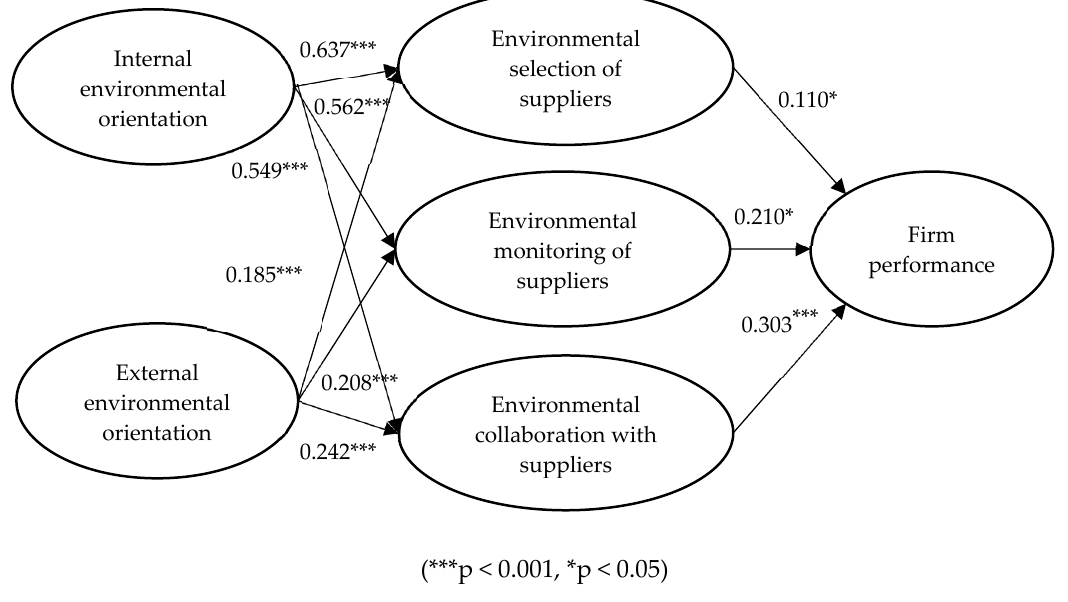
Figure 2. Hypotheses testing results.